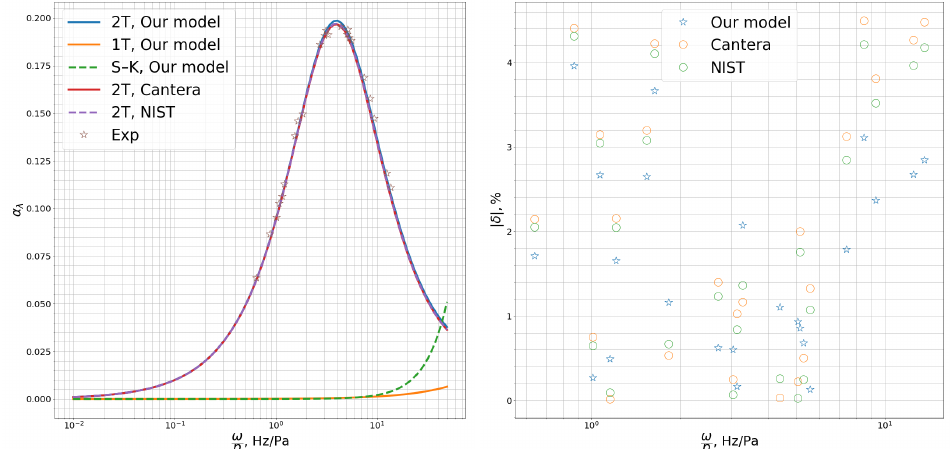
Figure 4. CO 2 . Comparison with experiment [93]. T = 195 ◦ C, p = 1 atm. ( Left ) dimensionless attenuation coefficient as a function of ω / p . ( Right ) deviation from the experiment for the 2T